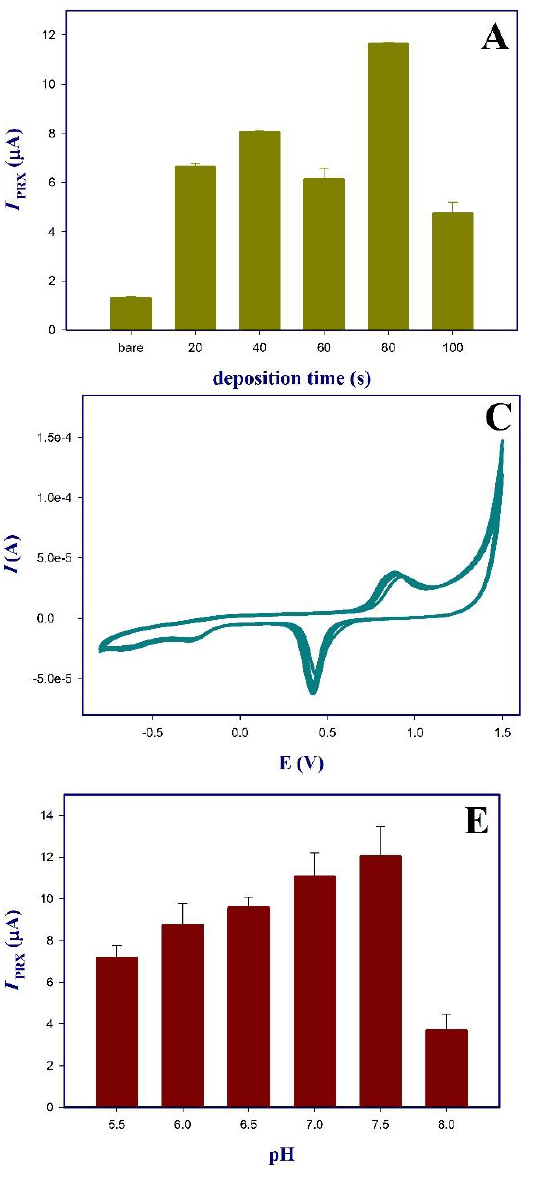
Figure 1. ( A ) Effect of AuNPs deposition time. ( B ) Effect of DL -met concentration on IPRX. ( C ) CV of five cycles electropolymerization of 0.5 mM DL -methionine in PBs pH 7 from − 0.8 V to 1.5 V at scan rate 0.1 V s − 1 on AuNPs-GCE. ( D ) Effect of number of scan cycles. Effect of pH media on the IPRX ( E ) and peak potential ( F ).